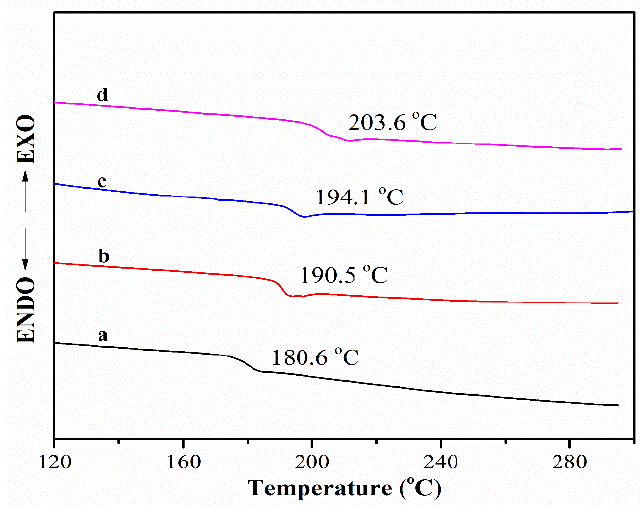
Figure 4. DSC of PEN–OH films heat-treated at different temperatures.